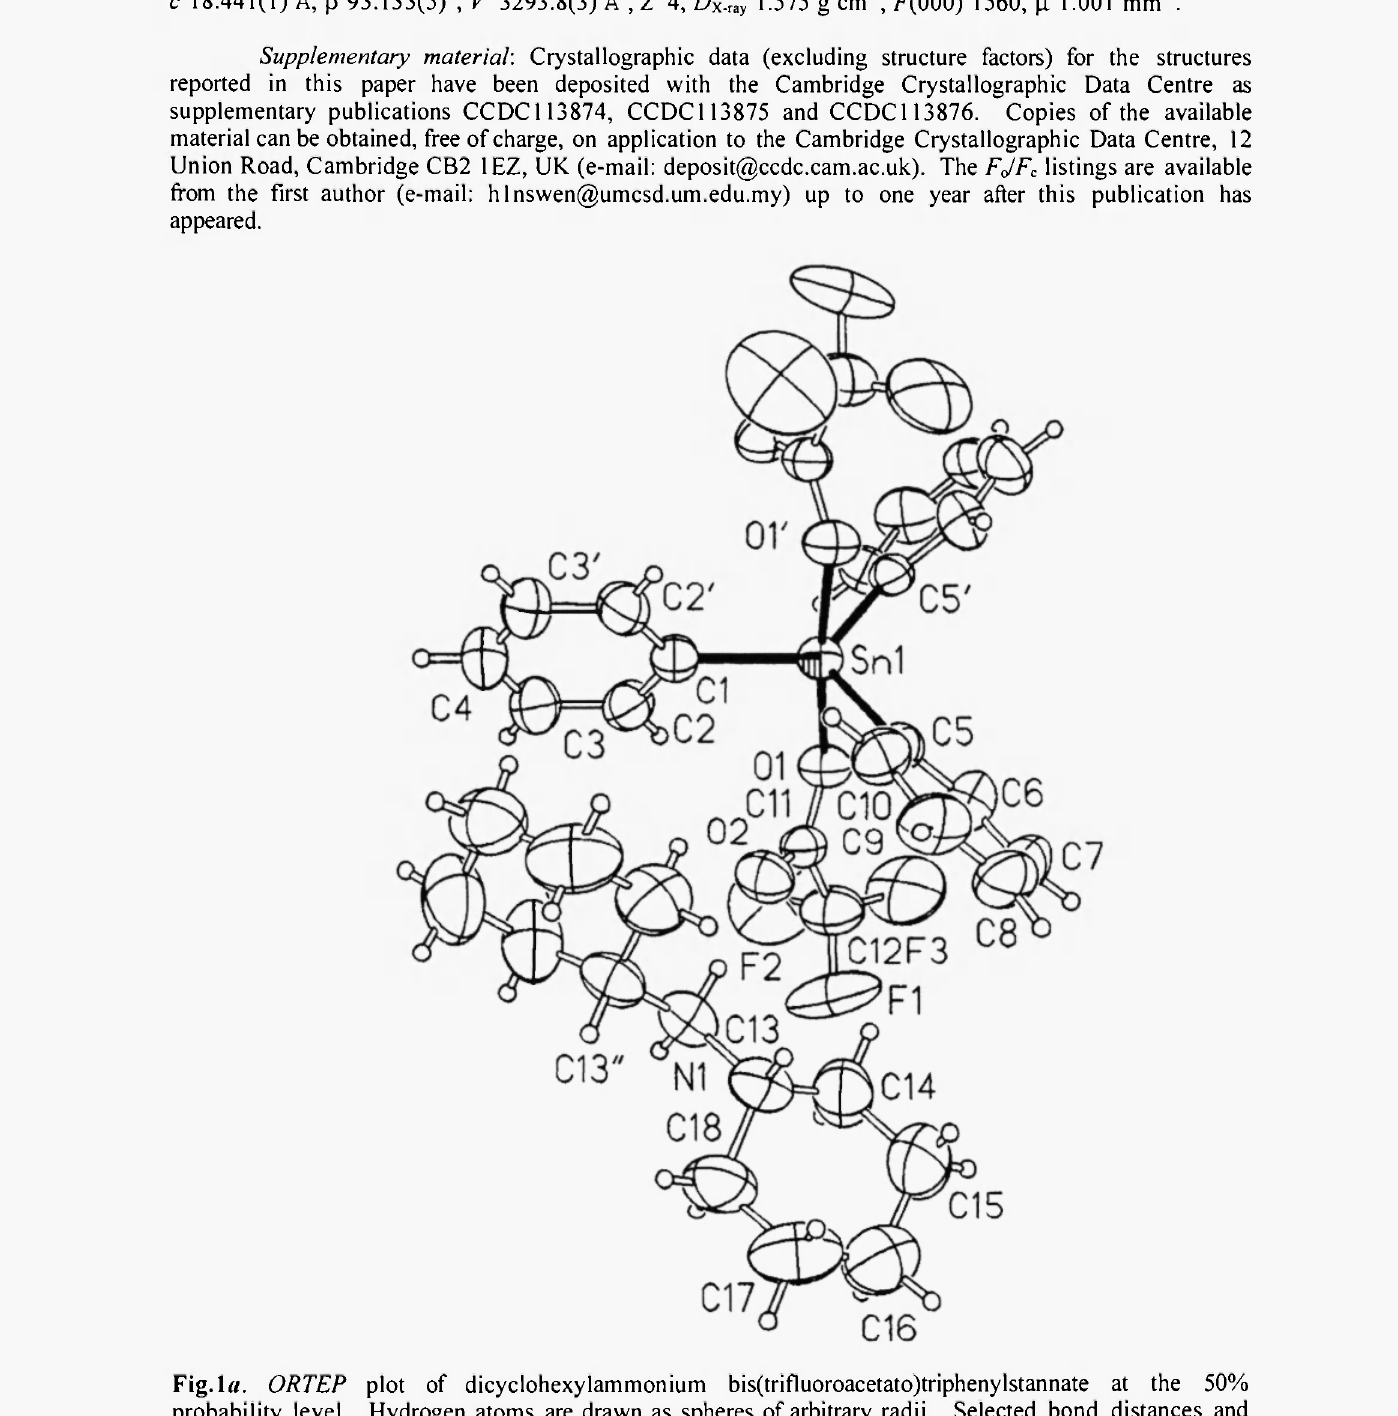
Fig.l«. ORTEP plot of dicyclohexylammonium bis(trifluoroacetato)triphenylstannate at the 50% probability level. Hydrogen atoms are drawn as spheres of arbitrary radii. Selected bond distances and angles: Snl-Cl 2.134(3) A, Snl-C5 2.133(3) A, Snl-C5 : 2.133(3) A, Snl-Ol 2.258(2) A,